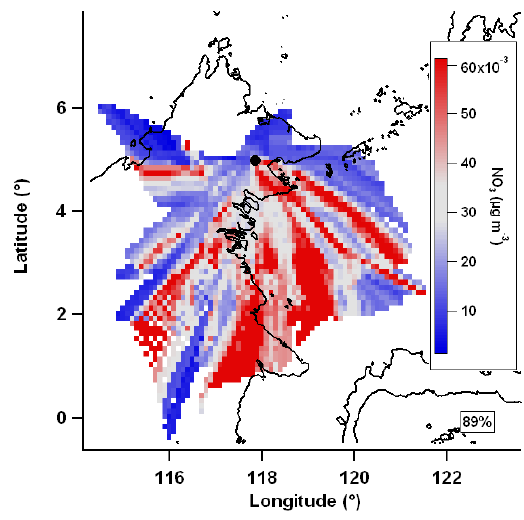
Fig. 11. Mean value maps for (a) methyl iodide, CH 3 I and (b) methyl bromide CH 3 Br. Grey is median value, red is greater than median, blue is less than median and white denotes no data coverage. 36h trajectories used.